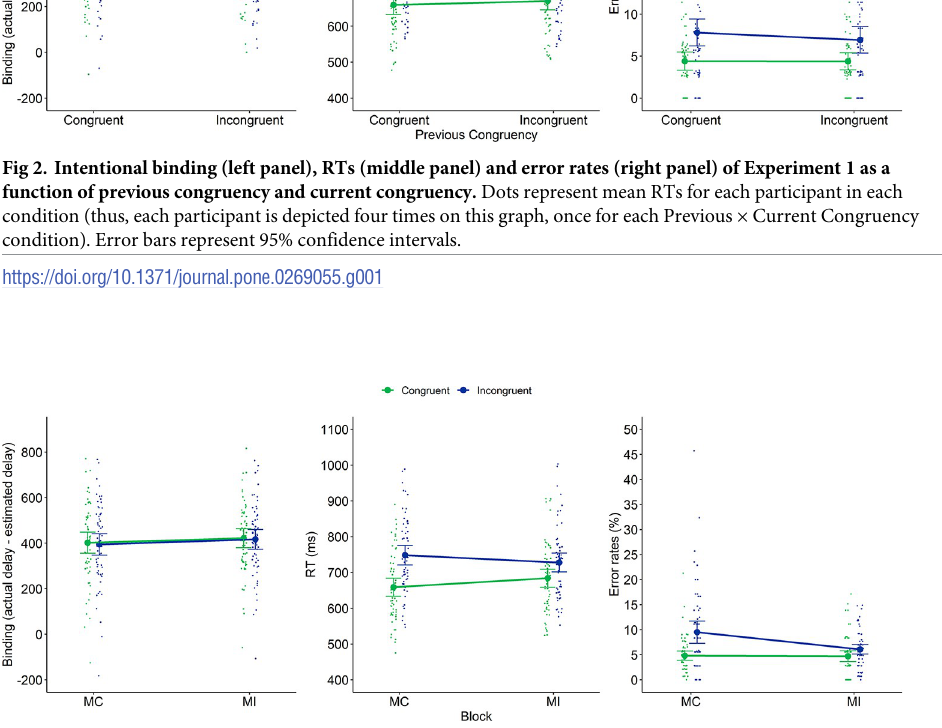
Fig 3. Intentional binding (left panel), RTs (middle panel) and error rates (right panel) of Experiment 1 as a function of Block and current congruency. Dots represent mean RTs for each participant in each condition (thus, each participant is depicted four times on this graph, once for each Block × Current Congruency condition). Error bars represent 95% confidence